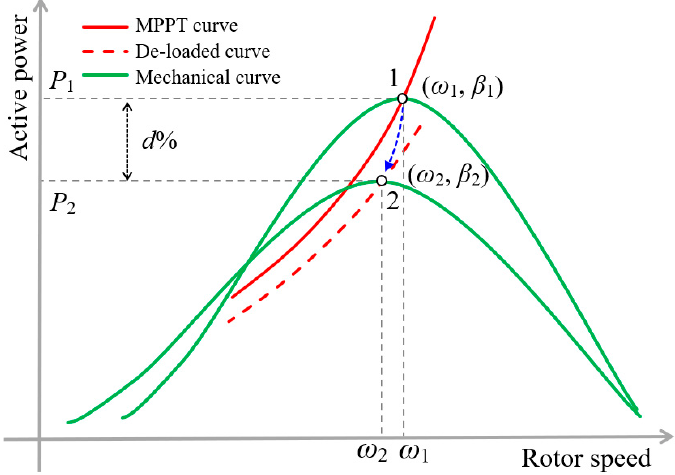
Figure 3. De-loaded operation by pitching strategy.